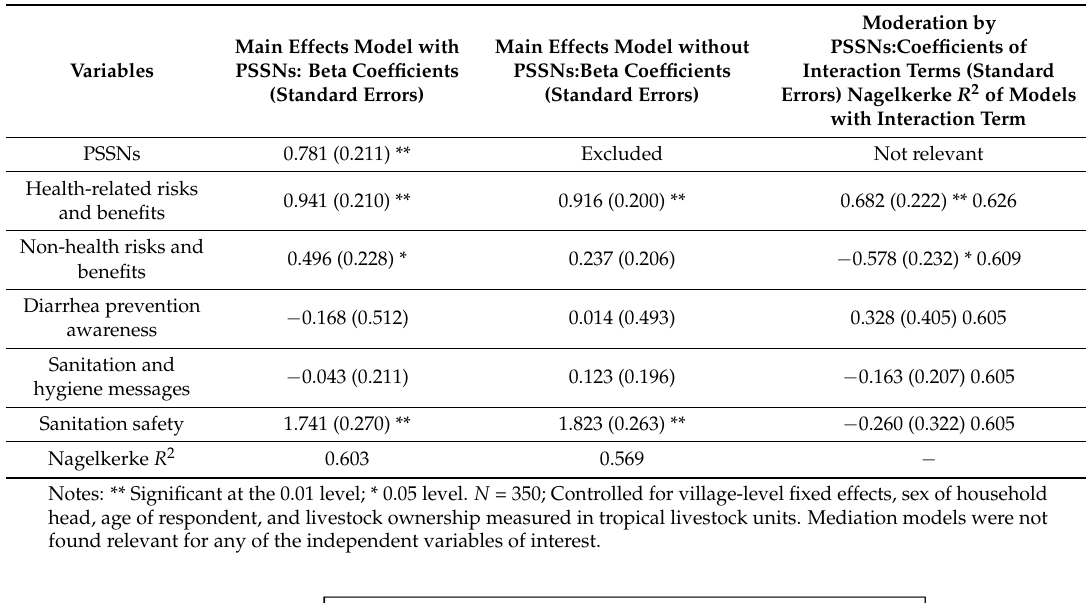
Table 4. Predictors of satisfaction with current sanitation practice (logistic regressions).